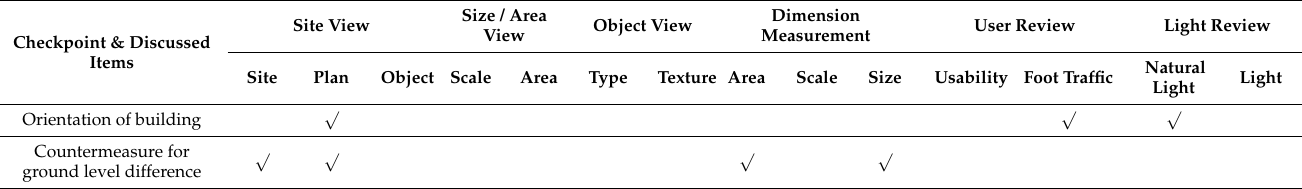
Table 3. Example of questionnaire items to determine development scope and functions of AR-based design review visualization.